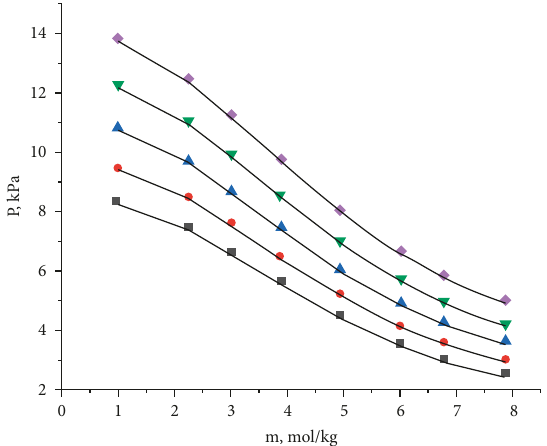
Figure 10: Calculation of the VLE for the CaCl2+H2O system. Symbols ( , T � 303.15 K; , T � 313.15 K; , T � 323.15K; , T � 333.15K; and , T � 343.15K :);VLE data; lines: calculation.